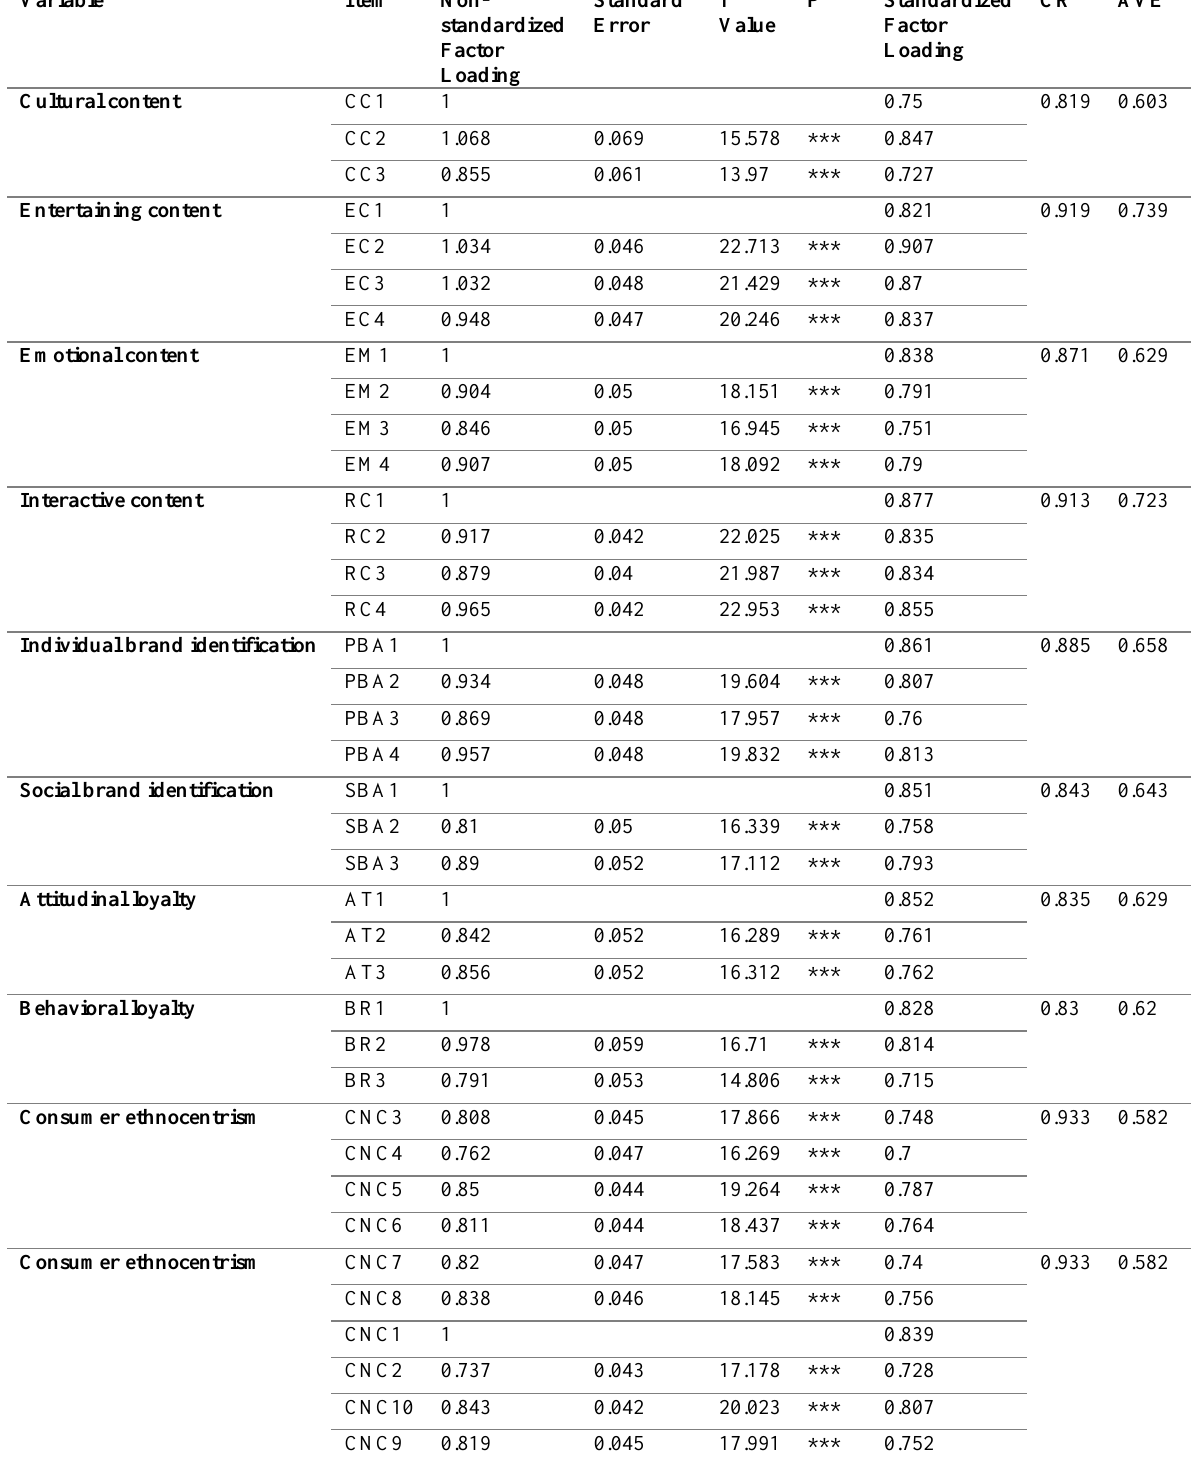
Table 4: CFA results of the global